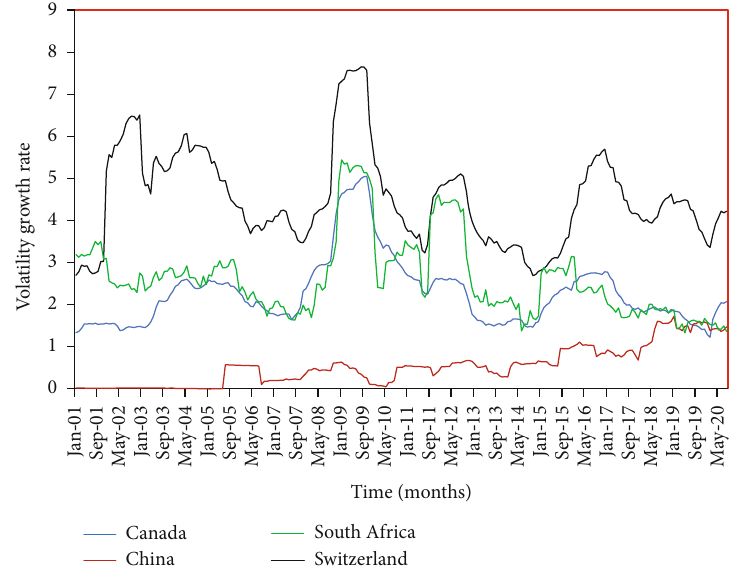
Figure 5: Trend analysis plots of moving volatilities of growth rate by country. Source: FRED,